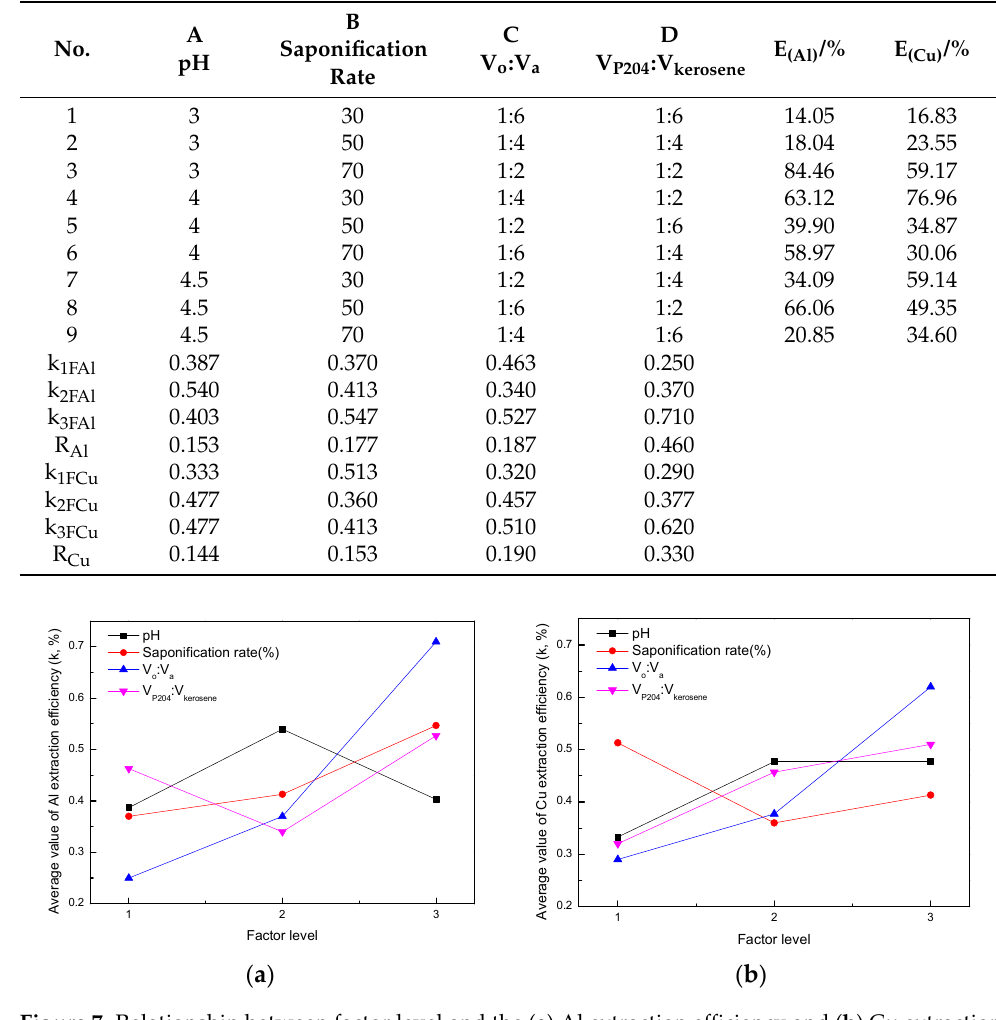
Figure 7. Relationship between factor level and the ( a ) Al extraction efficiency and ( b ) Cu extraction efficiency.